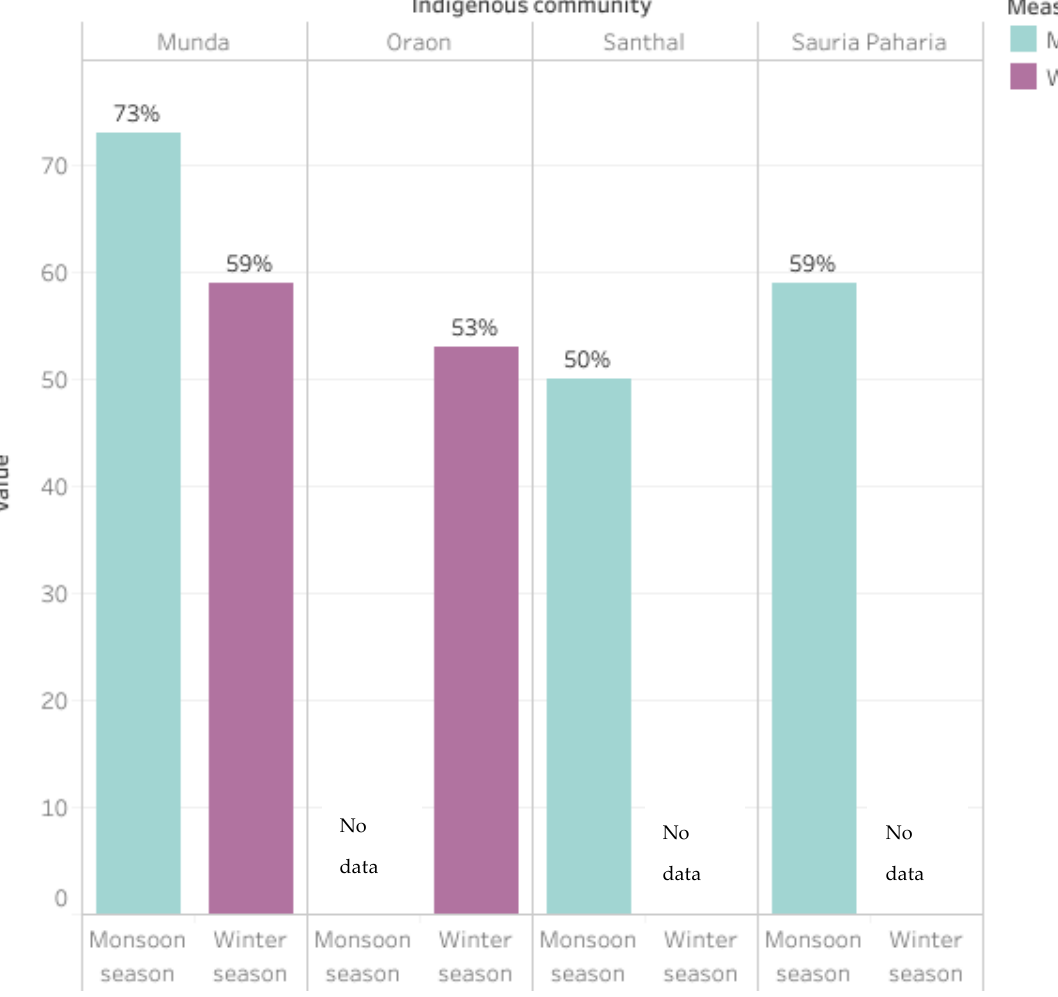
Figure 3. Estimates of traditional food consumption in indigenous women of Jharkhand, India [25,30,44,45].